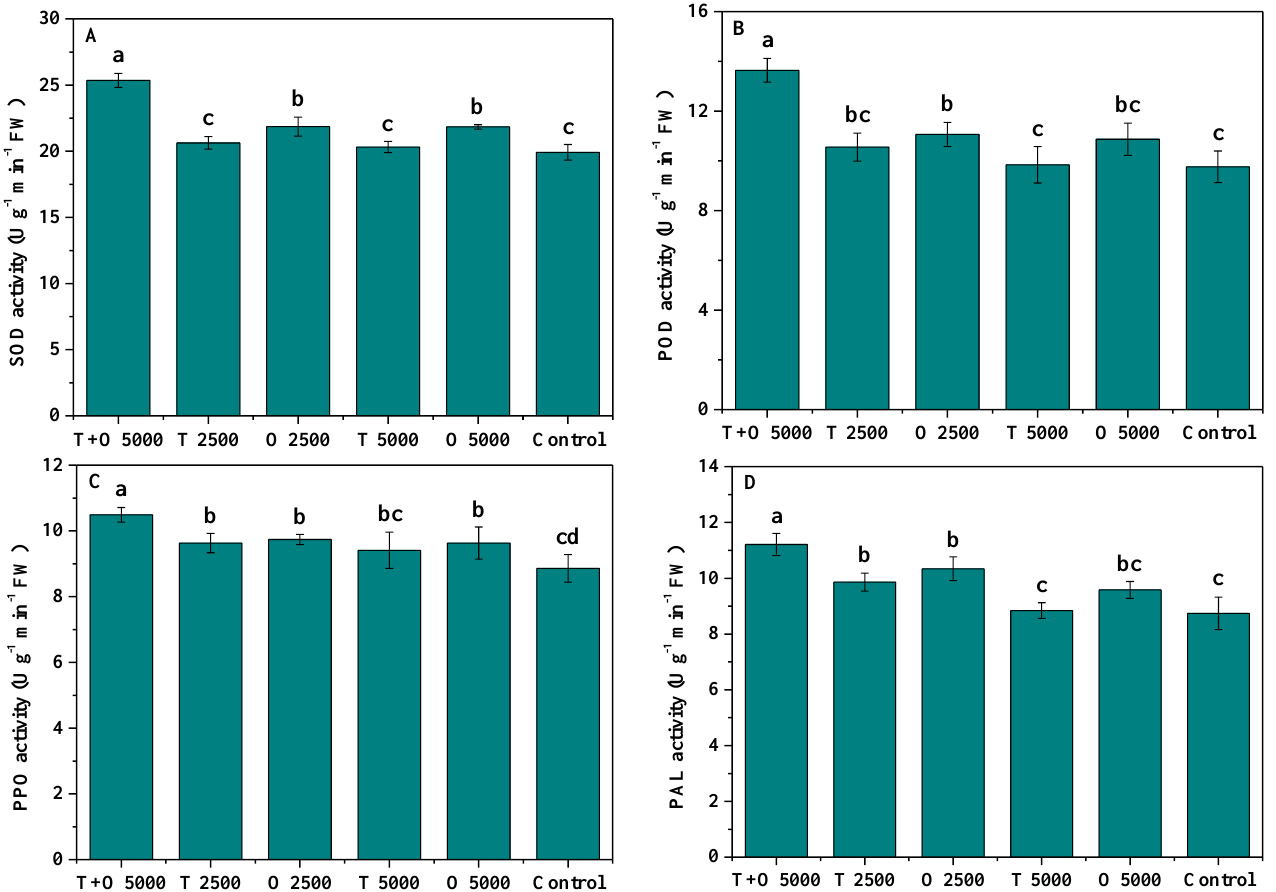
Figure 2. The effects of tebuconazole and oligosaccharins on SOD ( A ), POD ( B ), PPO ( C ) and PAL ( D ) activities in kiwifruit. Unit of all enzyme activities is U g − 1 min − 1 FW. The mean ± SD (n = 3) of three replicate is shown. The significant differences at 5% ( p < 0.05) are represented as different small letters.